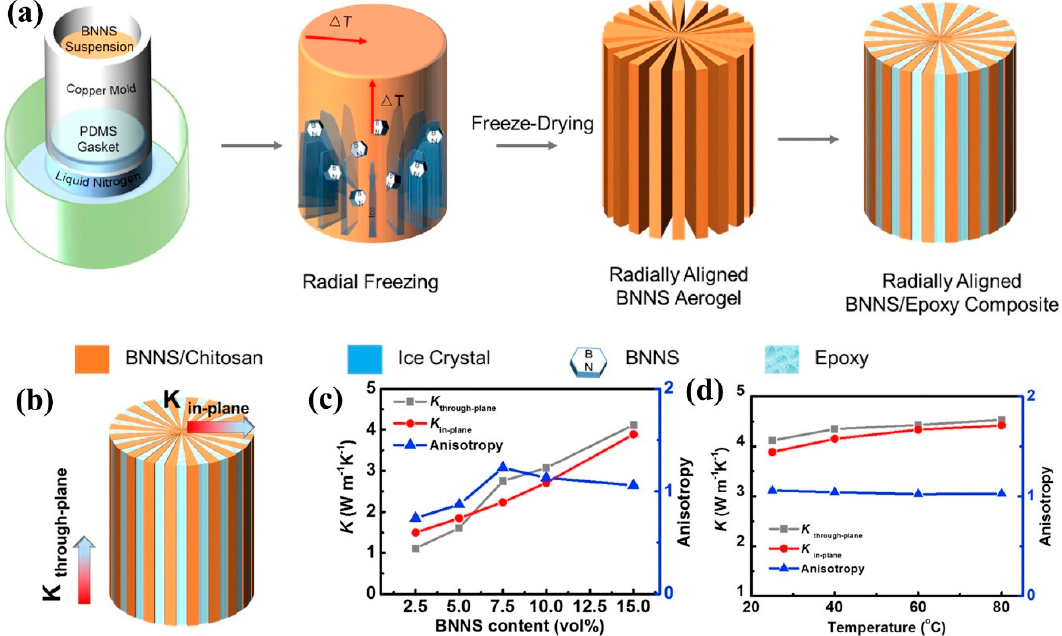
Figure 15. ( a ) Schematic illustration of the radially aligned BNNS / epoxy. ( b ) Schematic diagram of the thermal conductivity in the through-plane and in-plane directions. ( c ) Thermal conductivity of the BNNS / epoxy composites. ( d ) Change in thermal conductivity of BNNS / epoxy composites with temperature (reproduced with permission from [142]).